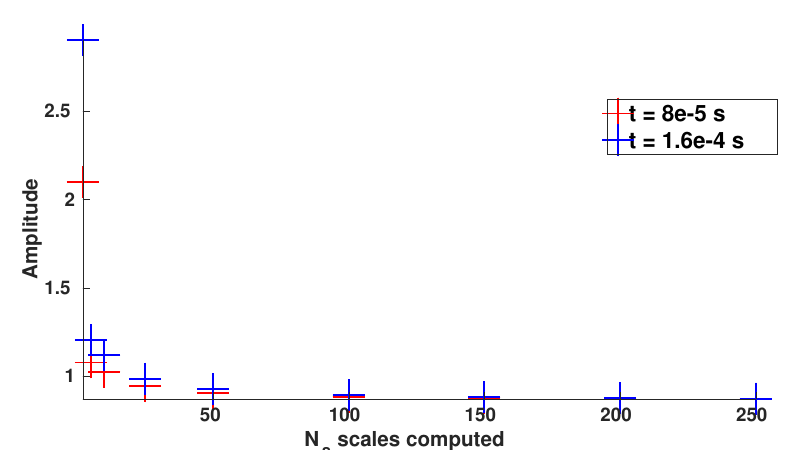
Figure 13. Reconstruction of the horizontal force applied to the microstructure - s ∈ [10 − 4 , 10 − 3 ].